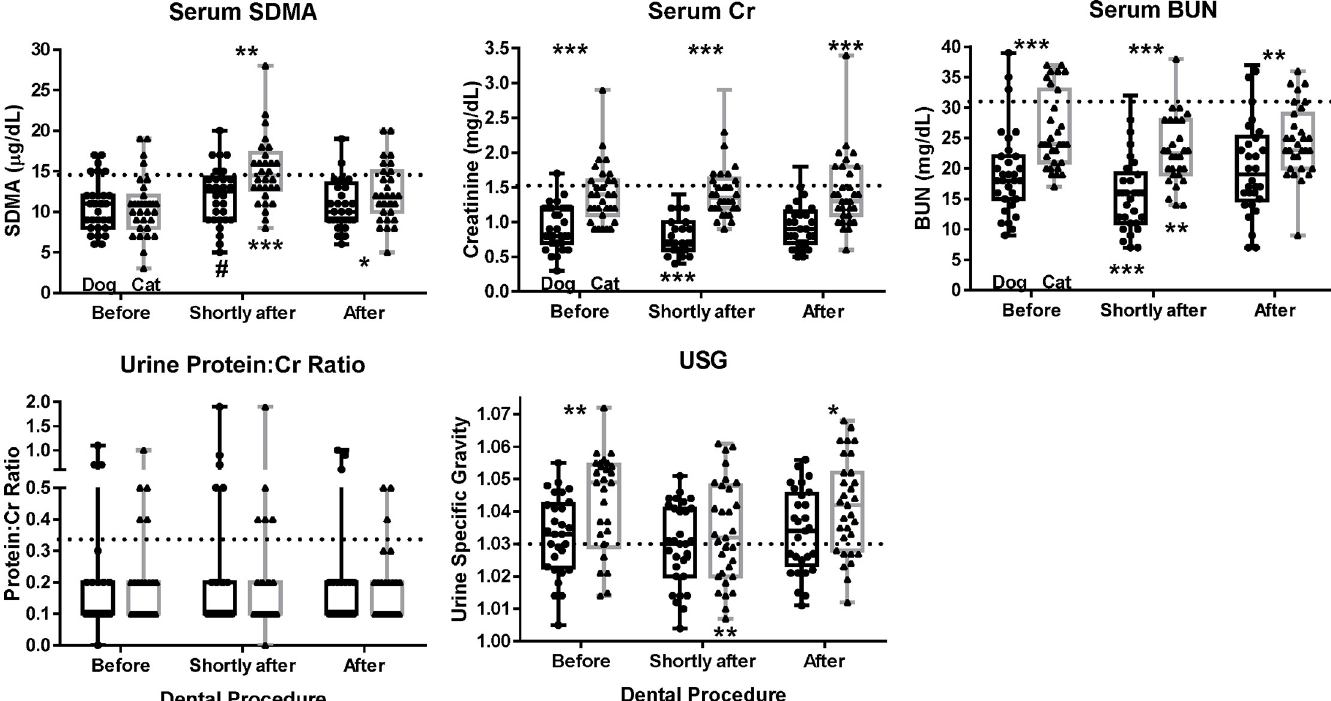
Fig 1. Serum and urine kidney function biomarker values before and after general anesthesia and dental cleaning procedures in cats and dogs with periodontal disease (n = 62). Serum and urine samples were collected from dogs and cats 1 week before, 6 hours after, and again 1 week after dental cleaning procedures. Samples were analyzed for serum creatinine (Cr), serum symmetric dimethylarginine (SDMA), and blood urea nitrogen (BUN), and urine for specific gravity (USG) and protein: creatinine (UPC) ratio. Results are shown as box and whiskers plots with individual points shown as filled circles for dogs and filled triangles for cats. The horizontal lines from bottom to top indicate minimum, 25 th percentile, median, 75 th percentile and maximum. Above the box and whiskers plots, differences between cats and dogs are denoted with a # for 0.10 � P � 0.05, a � for 0.05 � P � 0.01, a �� for 0.01 � P � 0.001, and a ��� for P � 0.001 and were calculated using the Wilcoxon rank sum test. Below the box and whiskers plots, changes from 1 week before dental procedures are denoted with a # for 0.10 � P � 0.05, a � for 0.05 � P � 0.01, a �� for 0.01 � P � 0.001, and a ��� for P � 0.001 and were calculated using a paired Wilcoxon rank sum test.